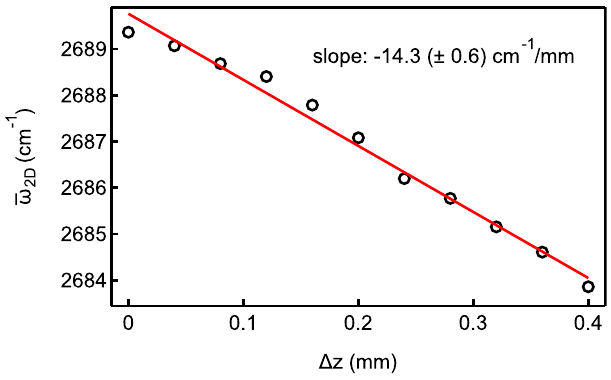
Fig. 5 Raman measurements for extracting the strain value. Spatially averaged center frequency (cid:1) ω 2D of the Raman 2D peak plotted as a function of the displacement Δ z . Black circles are data points. The error bars from the single Lorentzian fi tting when extracting the center frequency of the Raman 2D peak are smaller than the data points. The red line is a linear fi t to the data. The linear decrease with increasing Δ z indicates an increasing average